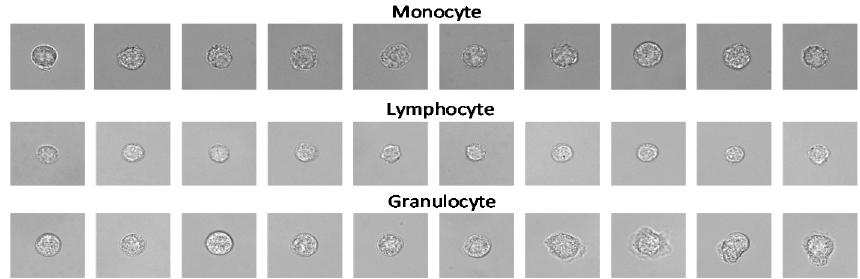
Figure 3. Examples of three-type WBC images in the datasets after segmentation.